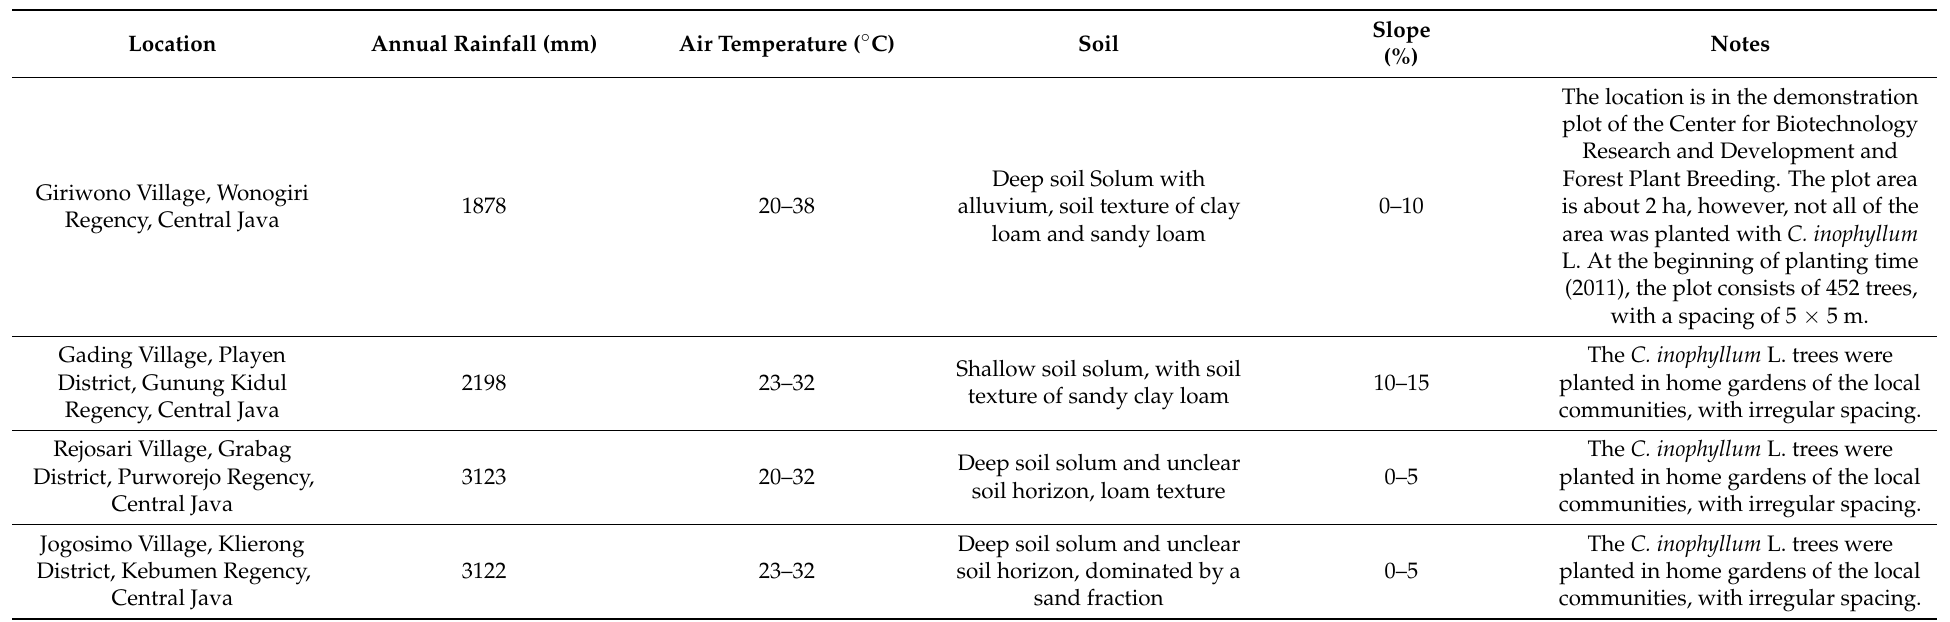
Table 1. Description of study